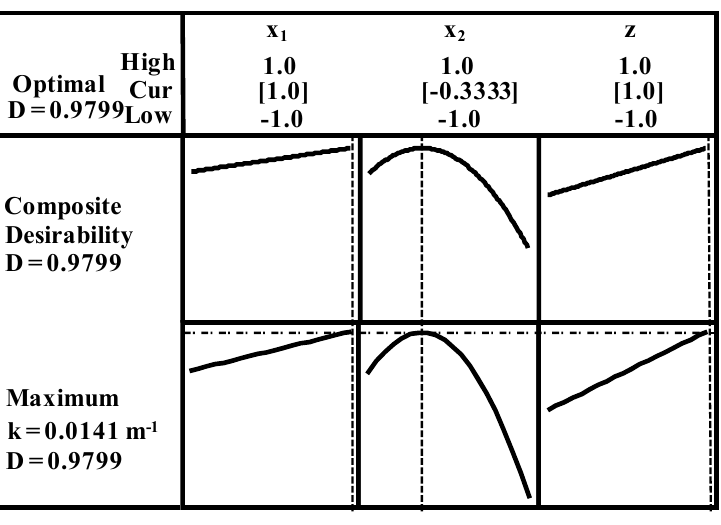
Figure 8. D-Optimality